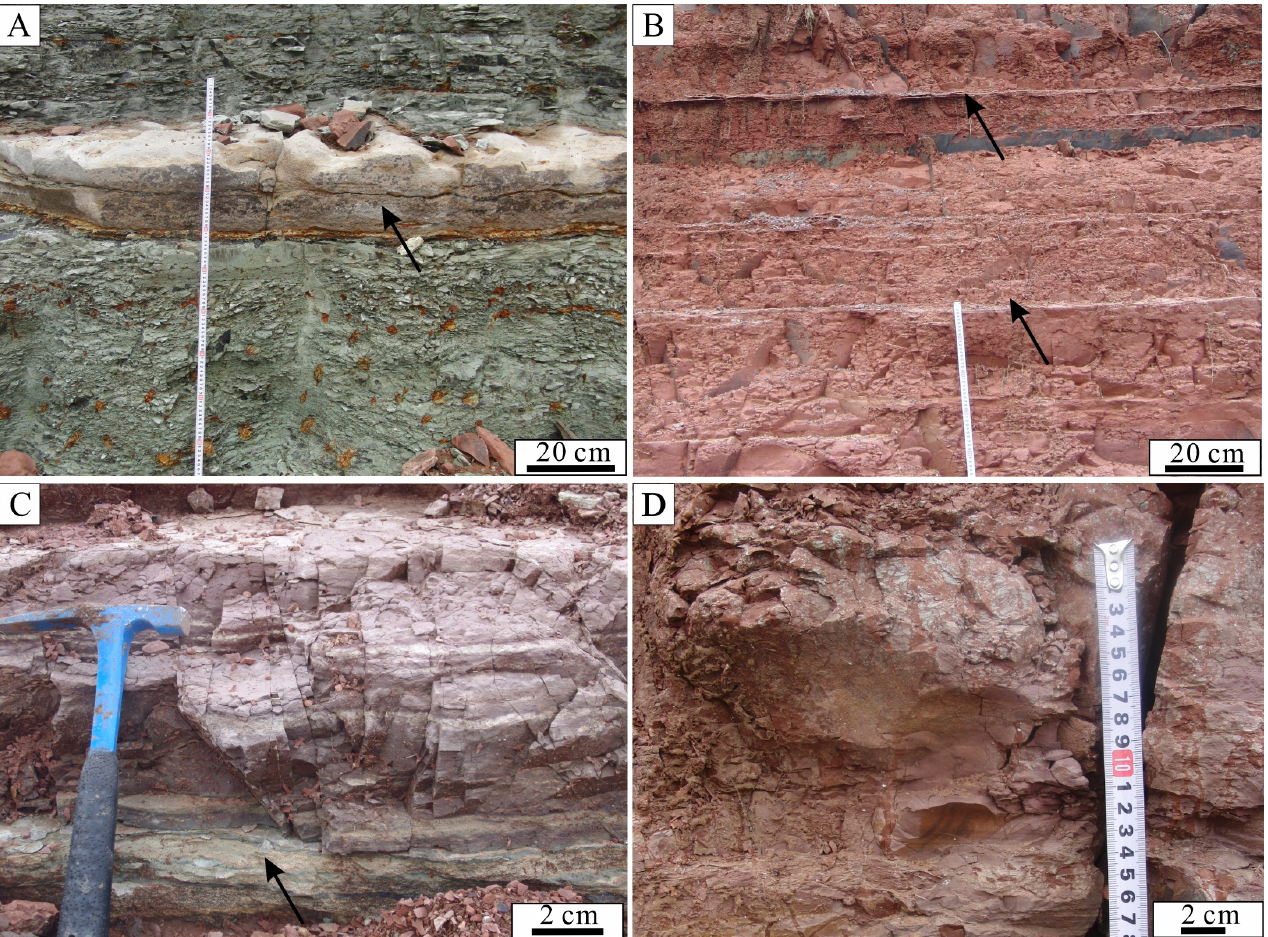
Figure 3. Sedimentary and pedogenesis characteristics of lake margin and shallow lake deposits. ( A ) Ostracod bearing limestone layer in celadon mudstone (marked with yellow arrow). ( B ) Reddish-brown paleosol with calcrete beds in lake margin facies (marked with black arrow). ( C ) Mauve mudstone and thin bedded limestone beds with a grayish-green mudstone interlayer (marked with black arrow). ( D ) Net-type paleosol with reticular, mottles marked with yellow arrow (modified after [27] ).